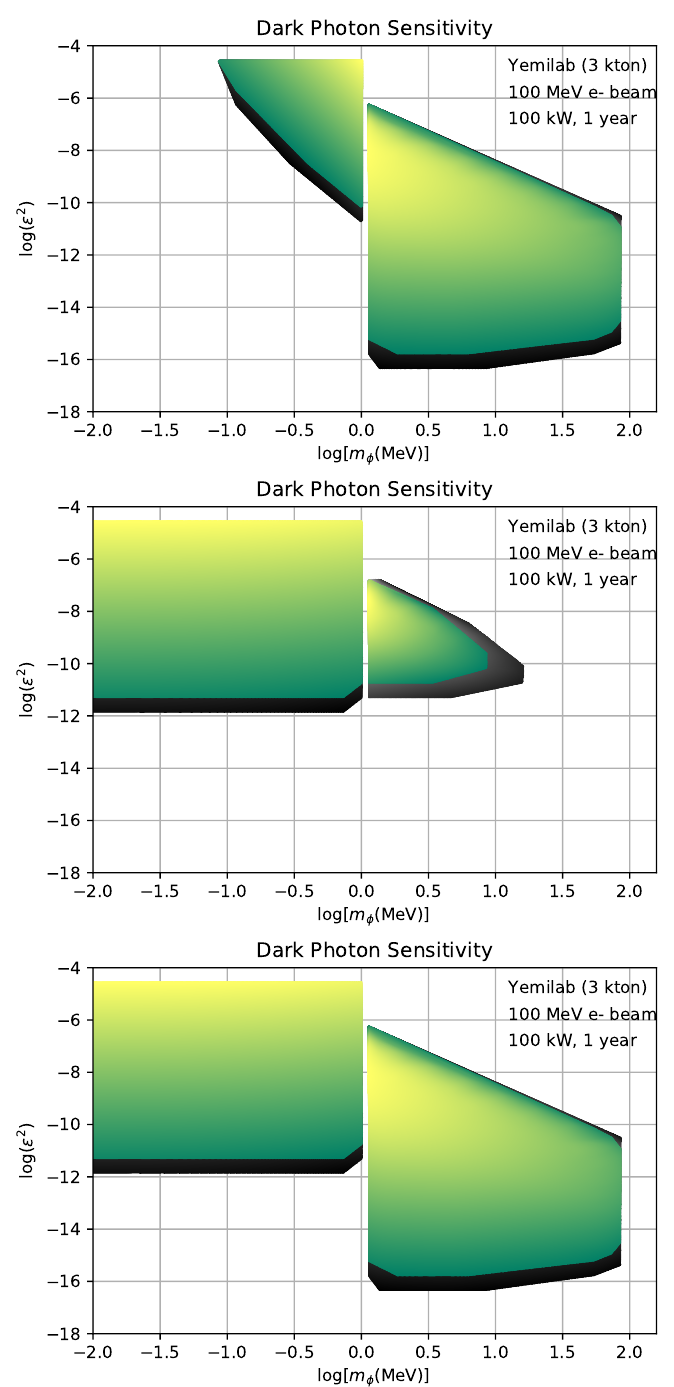
Figure 9 . Dark photon excluded regions (95% C.L. sensitivities) in the Yemilab neutrino detector for visible decays only (top), absorption-only (middle) and for both visible decays and absorption (bottom) for one year of data-taking with a 100 MeV–100 kW e − beam on a tungsten target (50 cm). Dark gray (green) region is the sensitivity obtained for zero ( 10 3 ) background events in both beam- ON and OFF